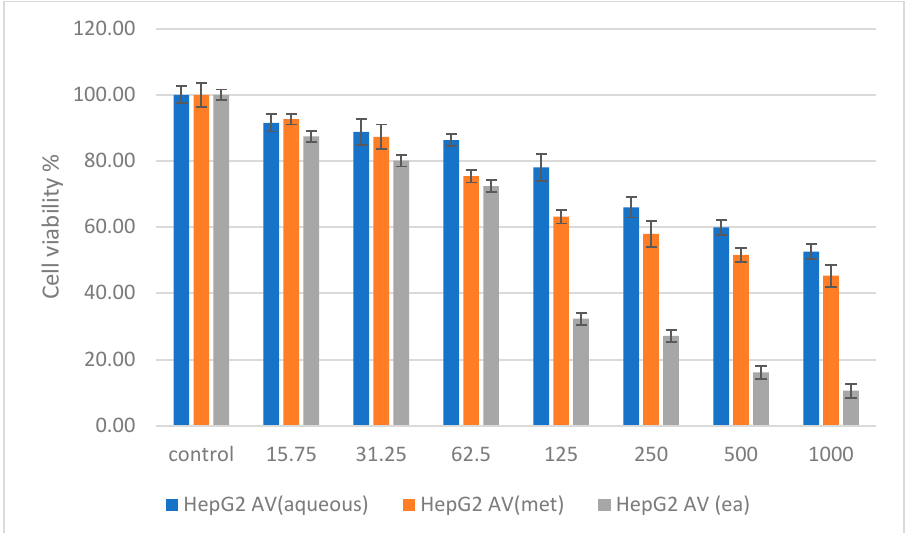
Figure 3. Cytotoxicity assay of Artemisia verlotiorum in aqueous, methanolic, and ethyl acetate extracts against human hepatocellular carcinoma HepG2 cells at 48 h.